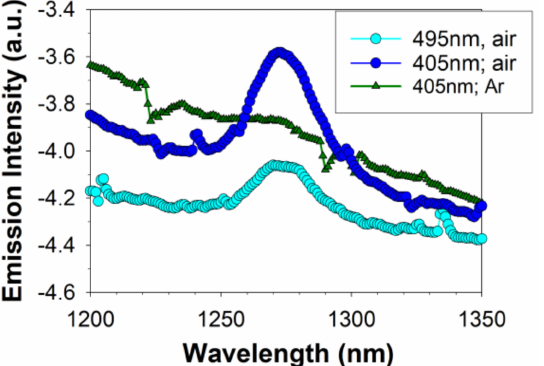
Figure 5. Photoexcitation of oxidised DHE (OxDHE) with blue light results in oxygen-dependent infrared emission with a maximum at 1270 nm. Near-infrared emission spectra from OxDHE solutions, saturated with air or argon (Ar), were collected during exposure to either 405-nm or 495-nm